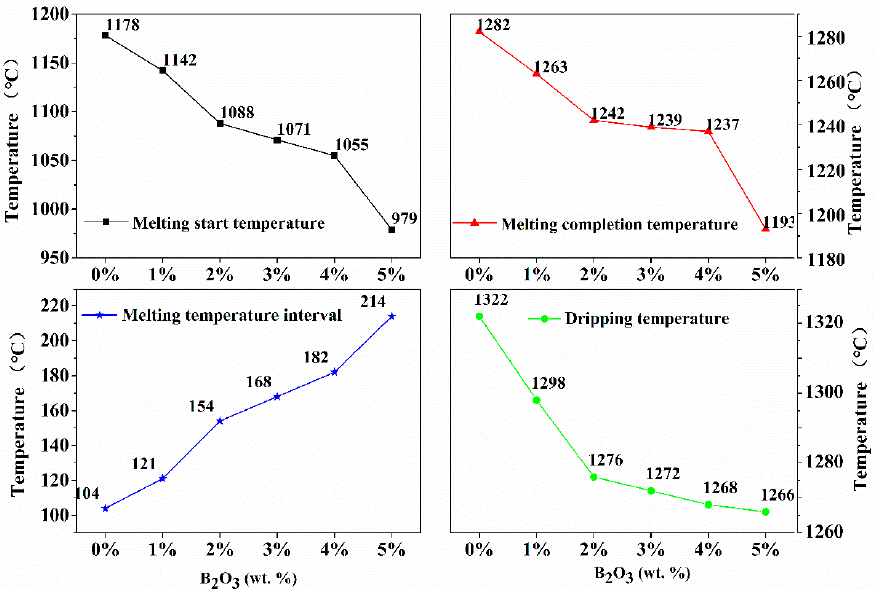
Figure 8. Melting and dripping temperatures of samples with B 2 O 3 addition.